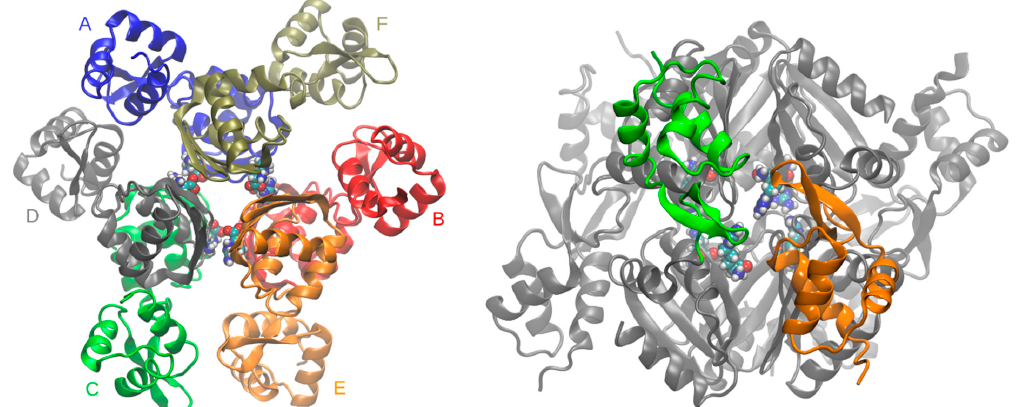
Figure 3. Model of holoBsArgR. The model was prepared as described in the text by docking six molecules of L-arg in the empty binding sites of the apoBsArgR crystal structure (PDB ID: 1F9N). Monomers are shown in cartoon representation in unique colors and labeled A–F. Atoms of L-arg are shown as spheres with atomic colors and cyan carbons. (Left) Top view down the 3 2 axis. The central C-terminal domains form two trimers stacked directly atop one another to form a hexameric core, and pairs of peripheral N-terminal DNA-binding domains (CE, green-orange; BF, red-tan; and AD, blue-grey) can be identified. (Right) Side view, rotated from the left panel by 90° about the z-axis and enlarged. This view shows that L-arg ligands are located at the trimer-trimer interface, and N-terminal domain pairs form across the trimer interface, illustrated for the green and orange CE subunits; all remaining subunits are in grey for clarity.